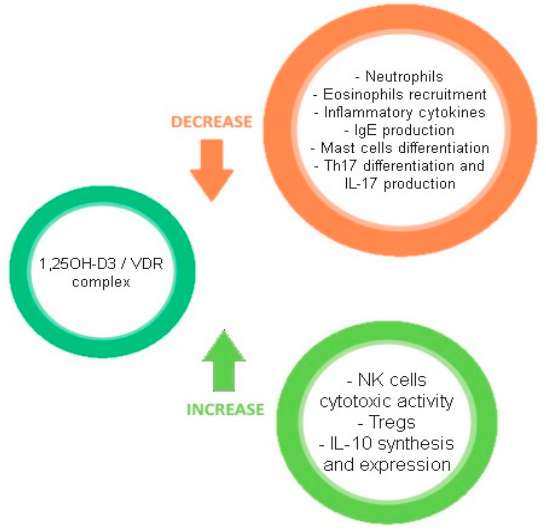
Figure 2. Effects of the VD/VDR complex on the immune system.